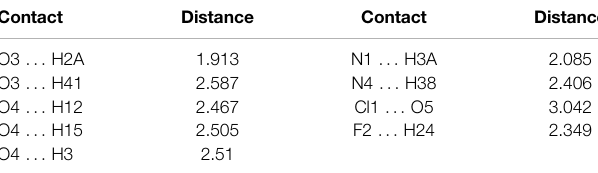
TABLE 2 | The short intermolecular contacts in 2a .